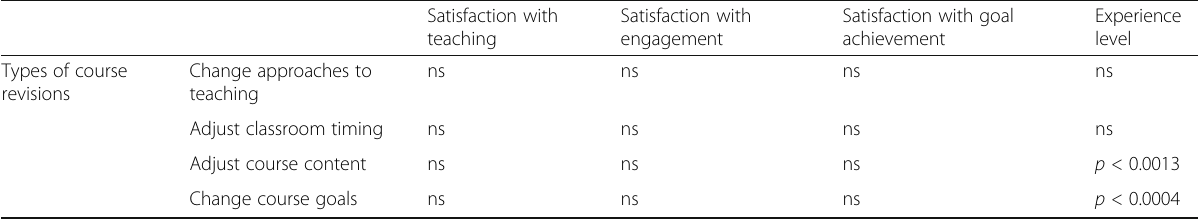
Table 3 Significance of correlations between course revisions codes and other